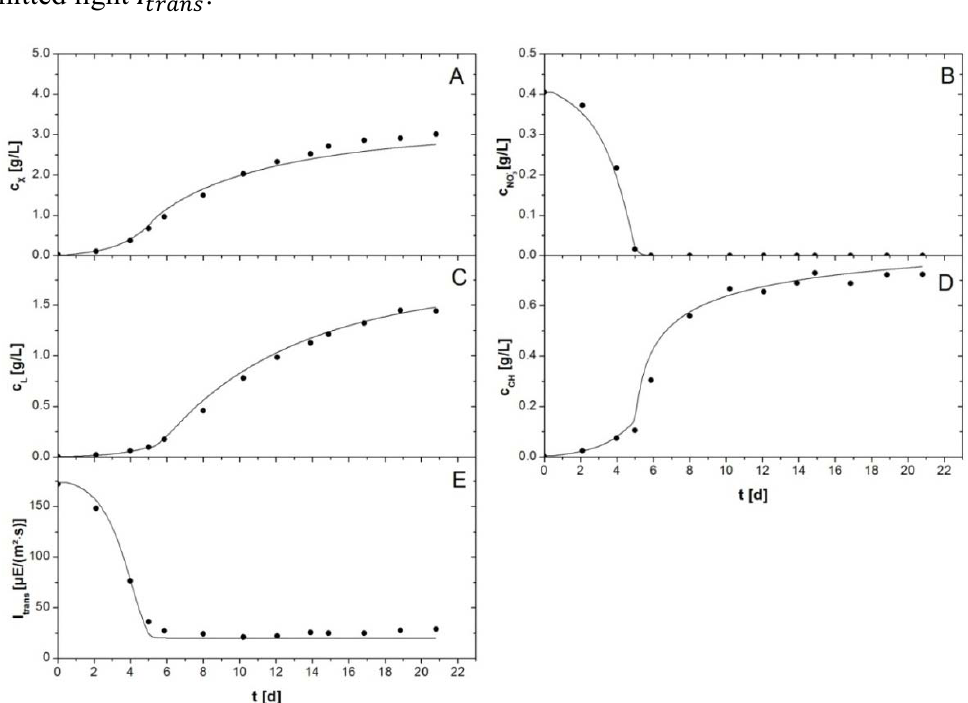
Figure 3. Batch cultivation of P. tricornutum with a NaNO starting concentration of 0.55 g/L. 3 Symbols indicate experimental data. Lines represent simulated data. ( A ) Biomass ; ( B ) Nitrate concentration (cid:1855) ; ( C ) Lipid concentration (cid:1855) comprises concentration (cid:1855) (cid:3025) (cid:3015)(cid:3016) (cid:3119)(cid:3127) (cid:3013) concentration of membrane lipids and TAGs, ( D ) Carbohydrate concentration (cid:1855) (cid:3004)(cid:3009) comprises concentrations of functional and storage carbohydrates; and ( E ) Irradiance of transmitted light (cid:1835) (cid:3047)(cid:3045)(cid:3028)(cid:3041)(cid:3046)